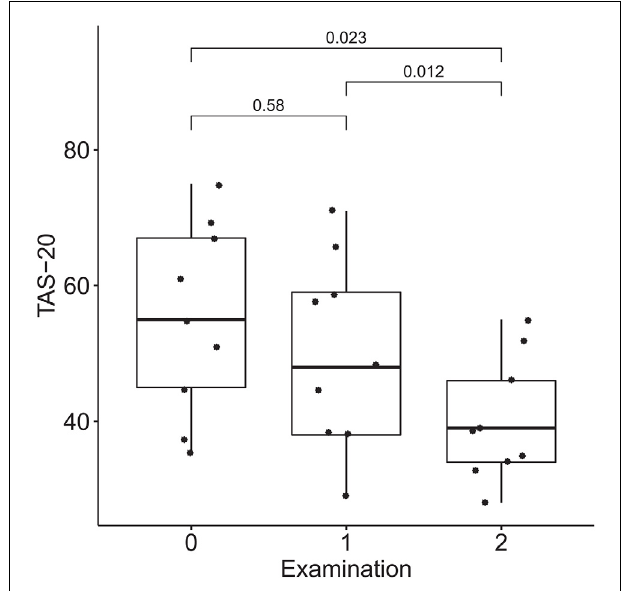
FIGURE 7 | Dynamics of alexithymia after the course of infra-low frequency neurofeedback. The examination was performed three times: (0) 2 to 4 months before enrollment, (1) at enrollment; and (2) after the neurofeedback course. Significance for the Wilcoxon pairwise comparisons is presented on the plot ( p -value, Bonferroni corrected).